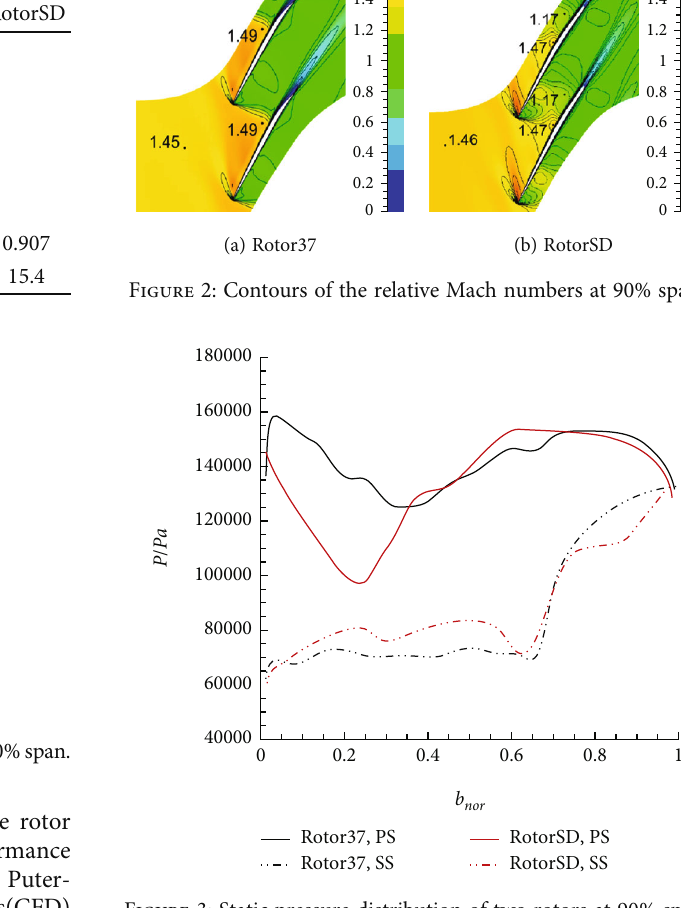
Figure 3: Static pressure distribution of two rotors at 90%